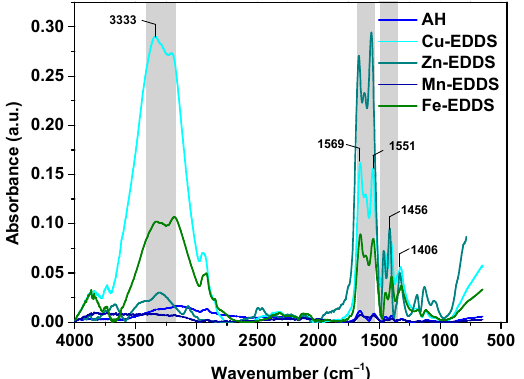
Figure 7. The FTIR-ATR spectra of the AH hydrogel before and after the sorption process of the Cu(II), Zn(II), Mn(II) and Fe(III) complexes with EDDS.